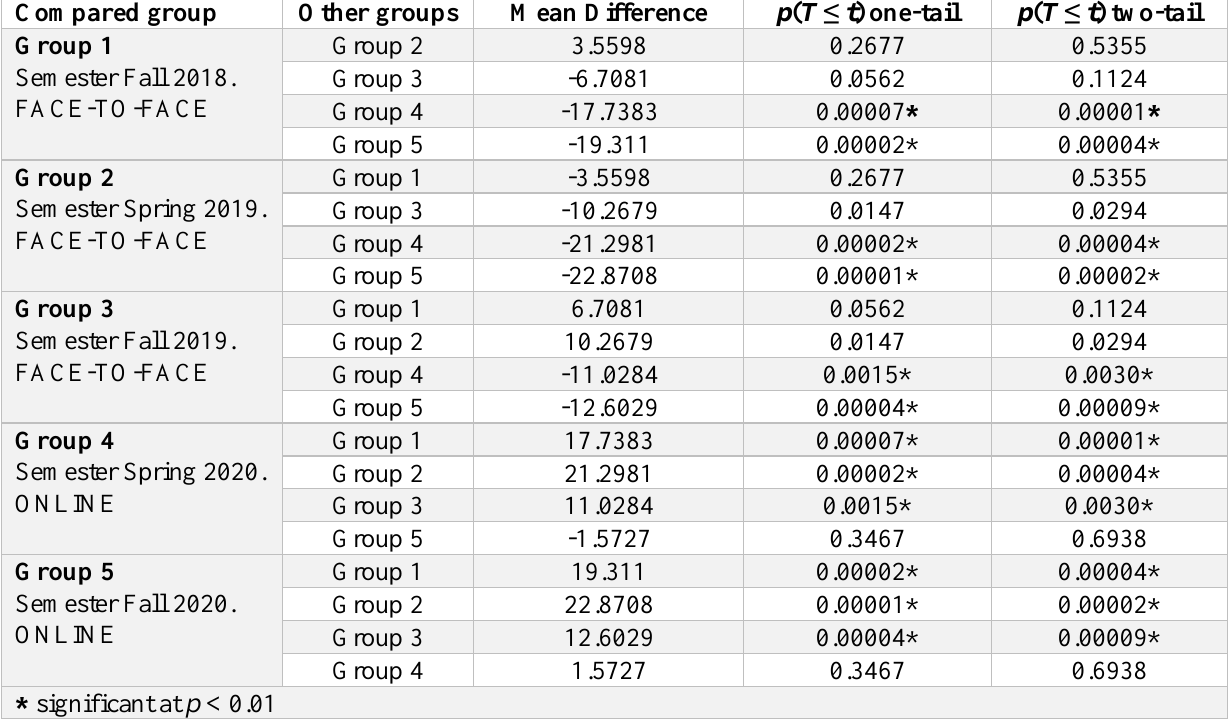
Table 2. Comparative t -test